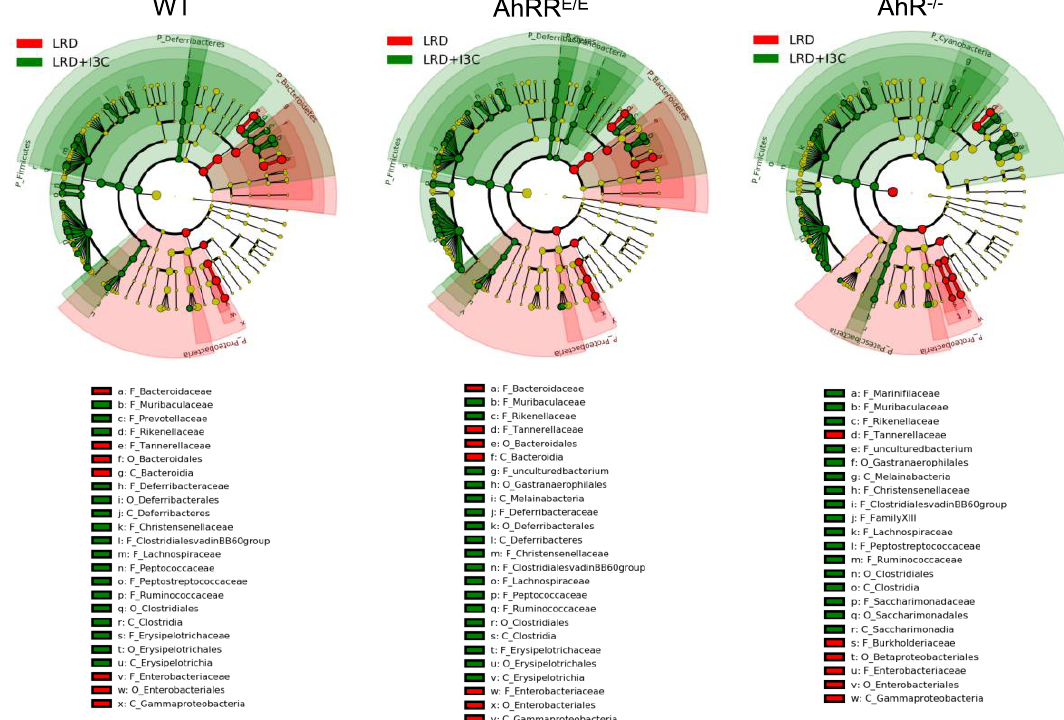
Figure 5. Taxonomic changes in the intestinal microbiome. LEfSe (linear discriminant analysis (LDA) coupled with e ff ect size measurement) was performed to identify taxa displaying the largest di ff erences in abundant microbiota using 16S rRNA sequences. Taxonomix cladograms of WT mice (left), AhRR E / E mice (middle), and AhR − / − mice (right) fed LRD or LRD + I3C. LRD enriched taxa are marked in green and LRD + I3C enriched taxa are marked in red. Taxa with linear discriminant analysis (LDA) scores > 2.0 and p < 0.05, determined using Wilcoxon signed-rank test, are shown.